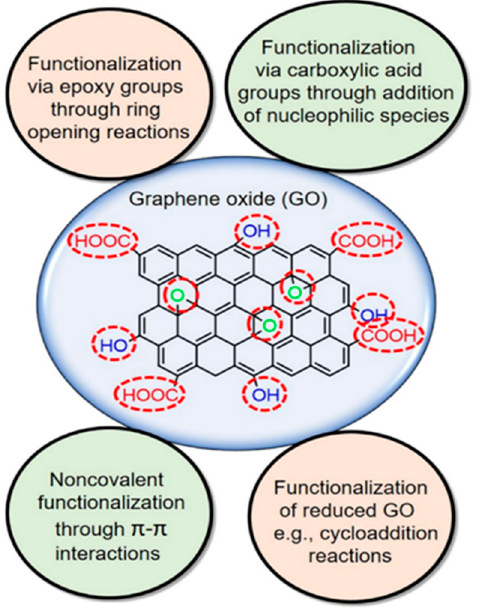
Figure 3. Different routes to graphene/graphene derivatives functionalization. Reproduced from Bilal, et al. [70]. Copyright (2020)